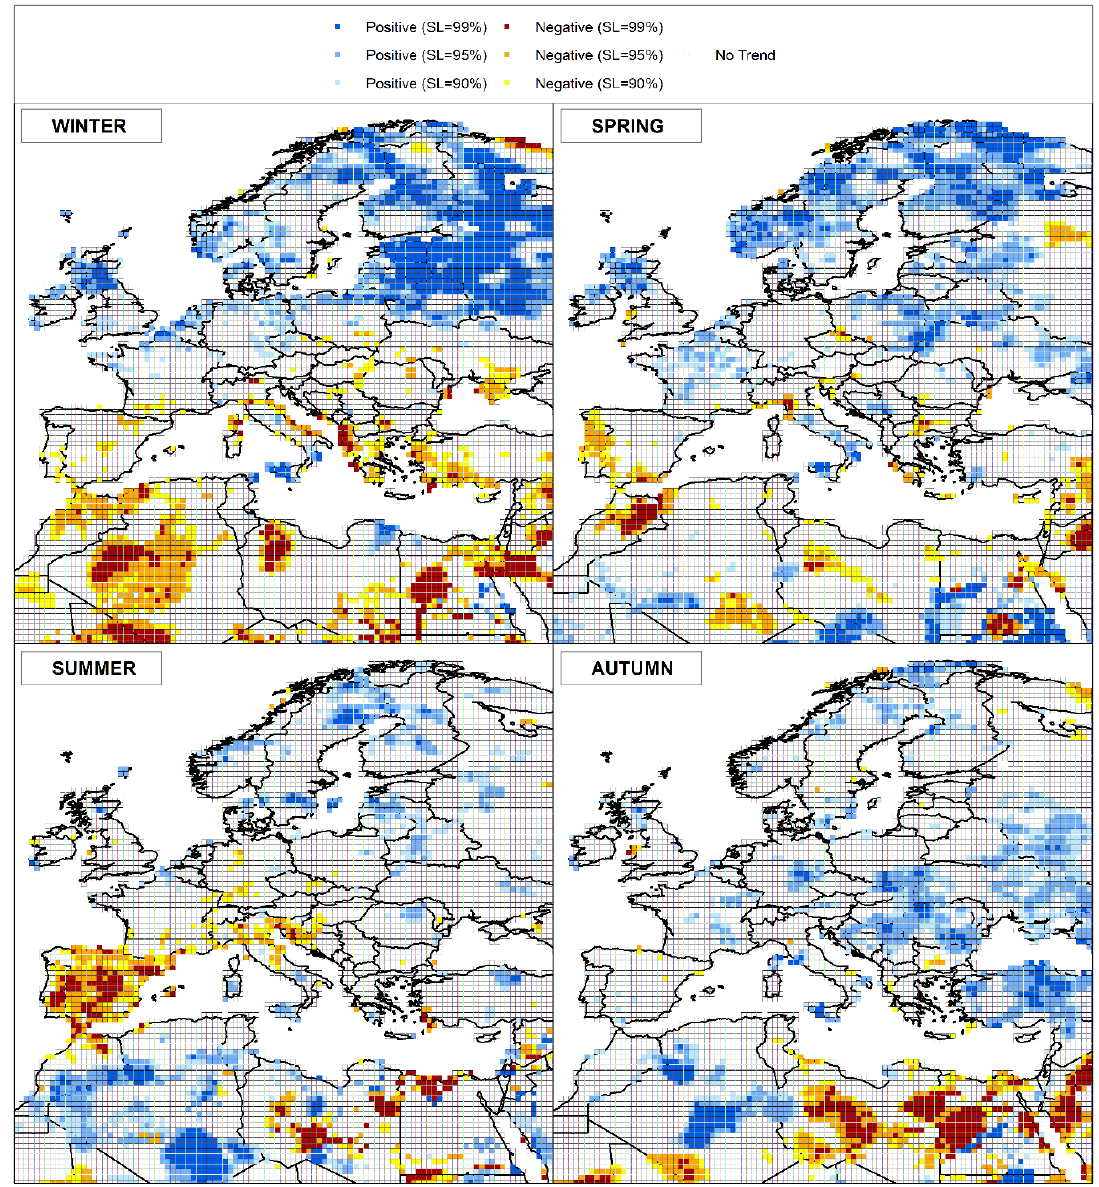
Figure 3. Spatial distribution of the grid points presenting positive or negative rainfall trends (seasonal scale). The trend analysis has been conducted at a seasonal scale, considering the 3-month SPI values in February for winter, in May for spring, in August for summer, and in November for autumn. Colored squares indicate significant positive or negative trends while white squares refer to a non-significant trend.